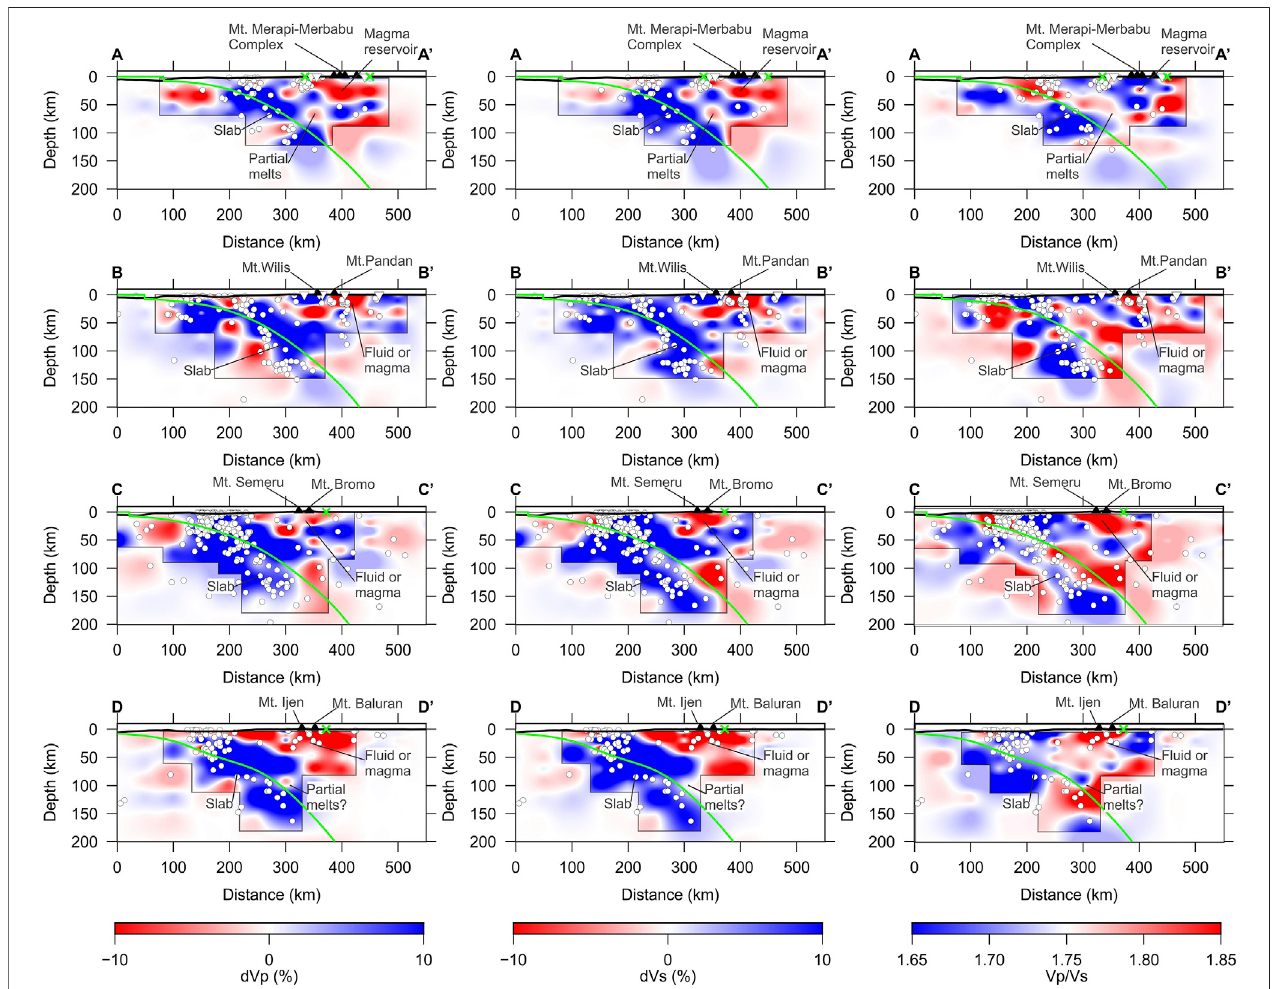
FIGURE5 | Vertical sections for Vp, Vsand Vp/Vs ratio withrelocated seismicity across Mt. Merapi-Merbabu (A-A 9 ) , Mt. Wilis-Pandan (B-B 9 ) , Mt. Semeru-Bromo (C-C 9 ) , and Mt. Ijen-Baluran (D-D 9 ) . Green lines and crosses indicate the slab 2.0 model (Hayes et al., 2018) and faults, respectively. Black triangles show locations of